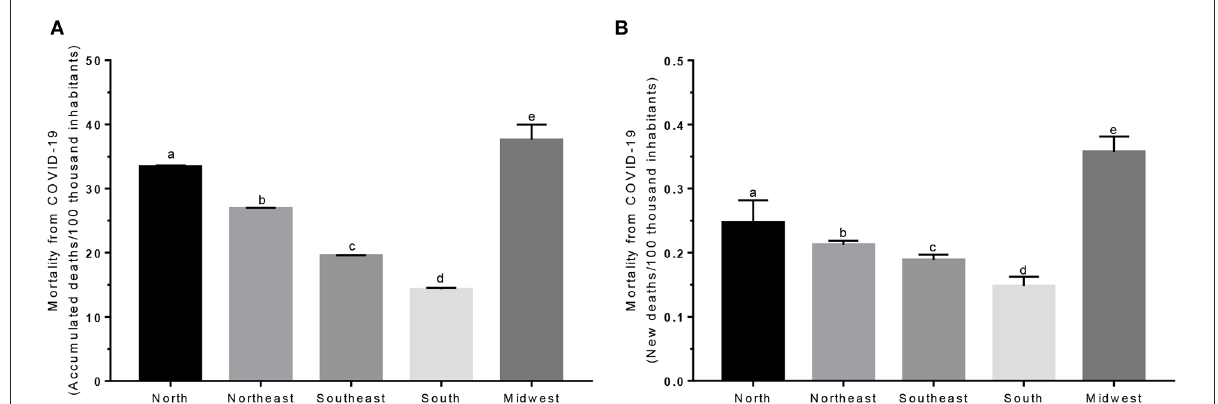
FIGURE3 Comparison evaluation of the average distributions of mortality from COVID-19 in Brazil for the year 2020. Data were previously collected from the digital collection and made available by the Ministry of Health, for the year 2020. (A) Comparison of the mortality accumulated per 100,000 inhabitants, by COVID-19 to the different macro-regions. (B) Comparison of the mortality of new cases per 100,000 inhabitants, due to COVID-19 in the different macro-regions. The Kruskal-Wallis test with Dunn’s multiple comparison post-test was used to compare the distributions. The letters a, b, c, d, and e demonstrate statistically significant differences, for p < 0.05.